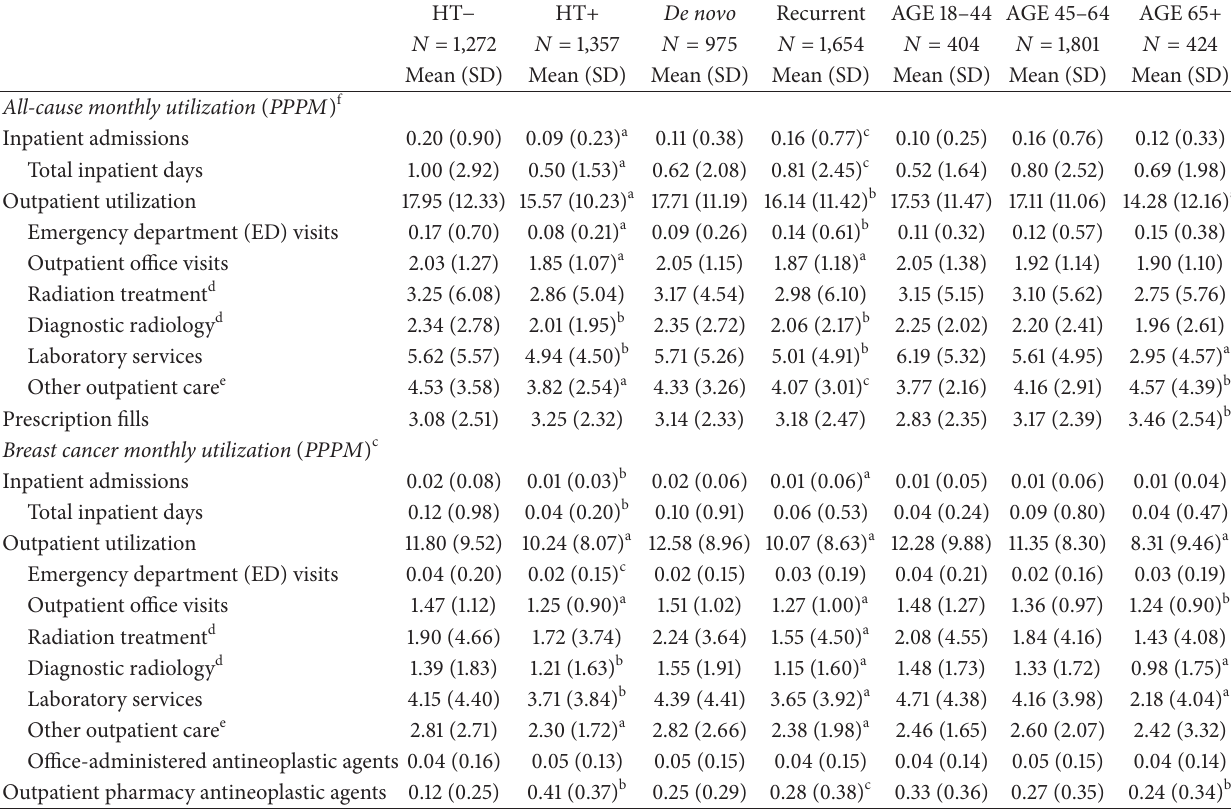
Table 4: Healthcare utilization during follow-up period among HER2-targeted agent